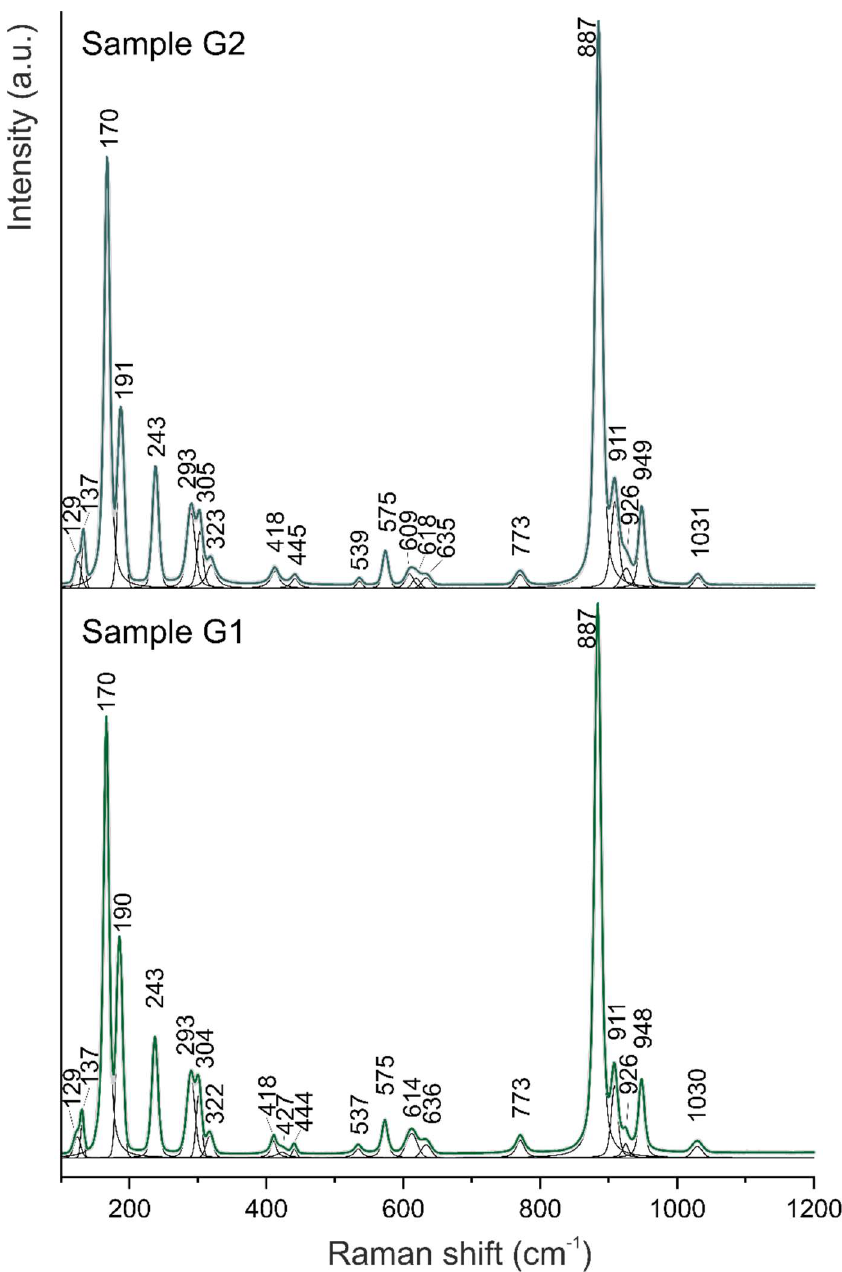
Figure 4. Raman spectra of genthelvite samples.